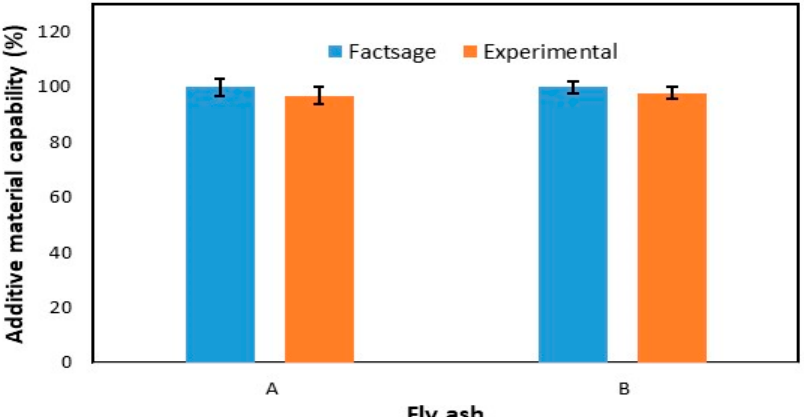
11 of 13 Figure 6. Mineral effect on controlling Cr 3+ during leaching process. 3.5. Comparison Result between Experiment and Simulation Similar to the laboratory experiment, the FactSage simulation was done by the addition of single and mixed additive materials. The result from FactSage also revealed that the three-additive mixture was useful in controlling the Cr leaching concentration from the fly ash. Additive materials’ capability is the capability of an additive material to control the Cr leaching concentration from the fly ash. As shown in Figure 7, there were no significant differences between the laboratory experiments and FactSage simulations. This figure shows the capability of the three-additive mixture to control the leaching of Cr from fly ash A and B. The Cr controlled from fly ash A by FactSage and the laboratory experiments were 99.98% and 96.91%, respectively; those from FA B were 99.92% and 97.78%, respectively, where error percentages of experimental analysis to FactSage analysis of FA A and FA B were 3.07% and 2.15%, respectively. In a previous research, leaching test results were